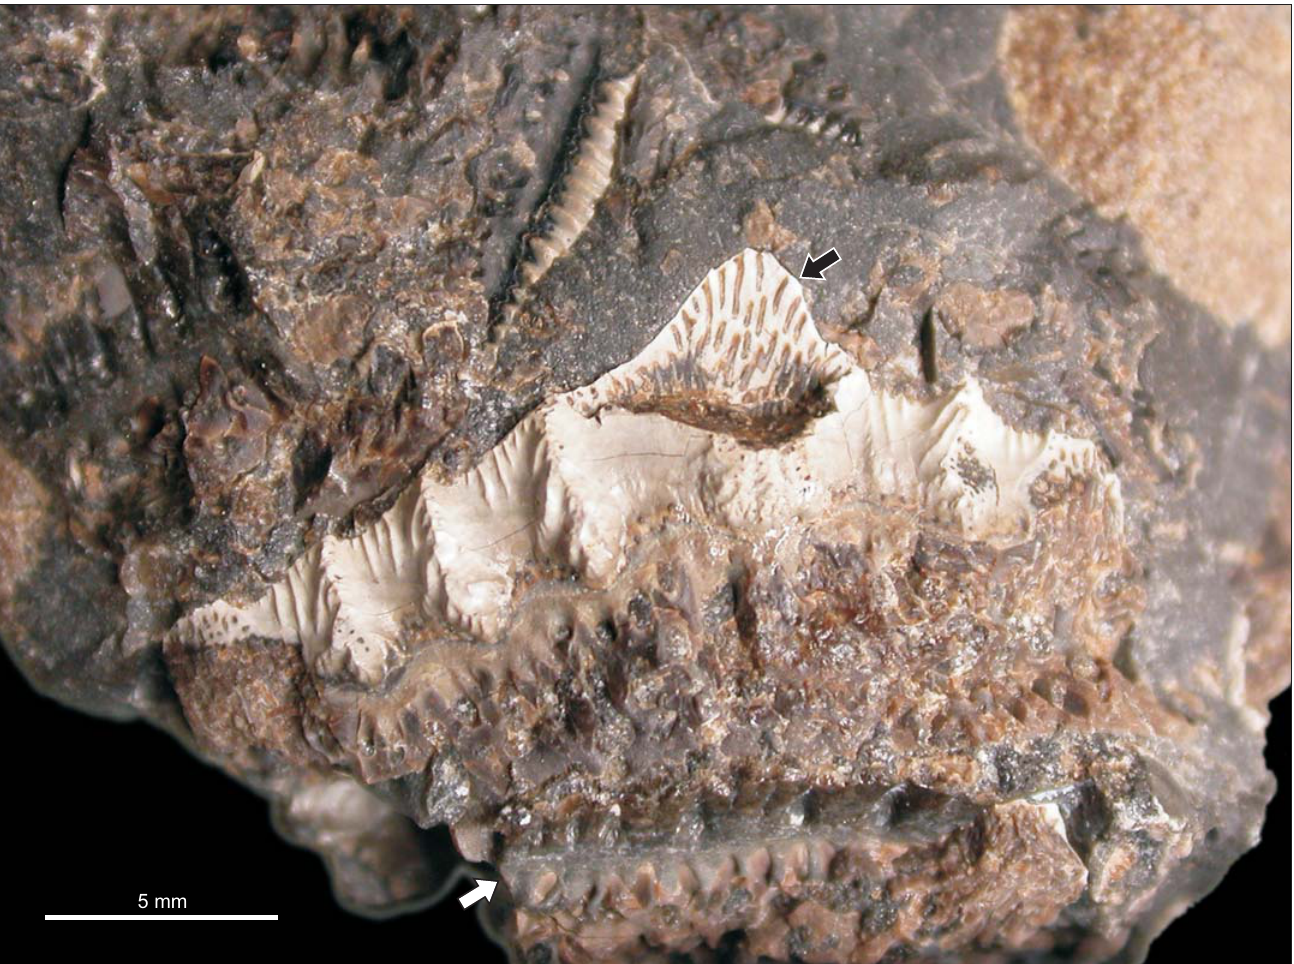
Fig. 5. The largest and best preserved tooth (GSM 105459) of the eugeneodontiform shark Campodus agassizianus De Koninck, 1844 from the Kinder- scoutian of Derbyshire, UK. Note the tubular dentine in the broken median cusp (black arrow) and a probable bar-like tooth at the bottom of the photo- graph (white